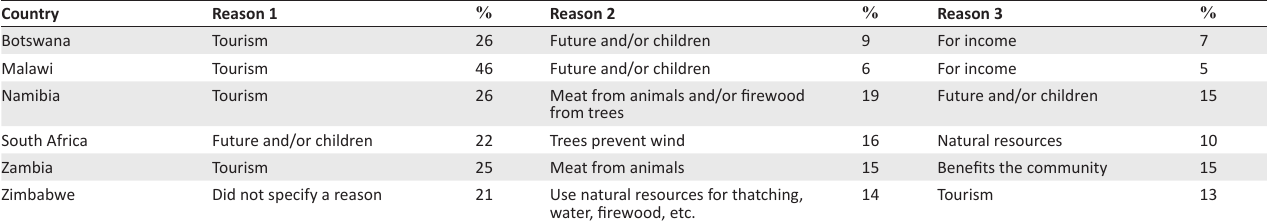
TABLE 4: Main reasons given for the importance of conservation by location.